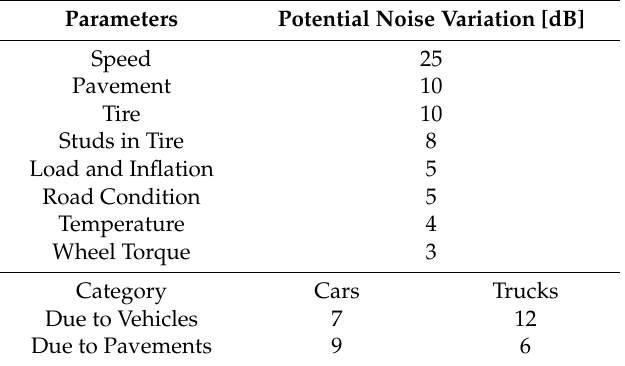
Table 1. Overview of parameters affecting Tire–Pavement Interaction Noise (TPIN) (summarized from Sandberg and Ejsmont, 2002